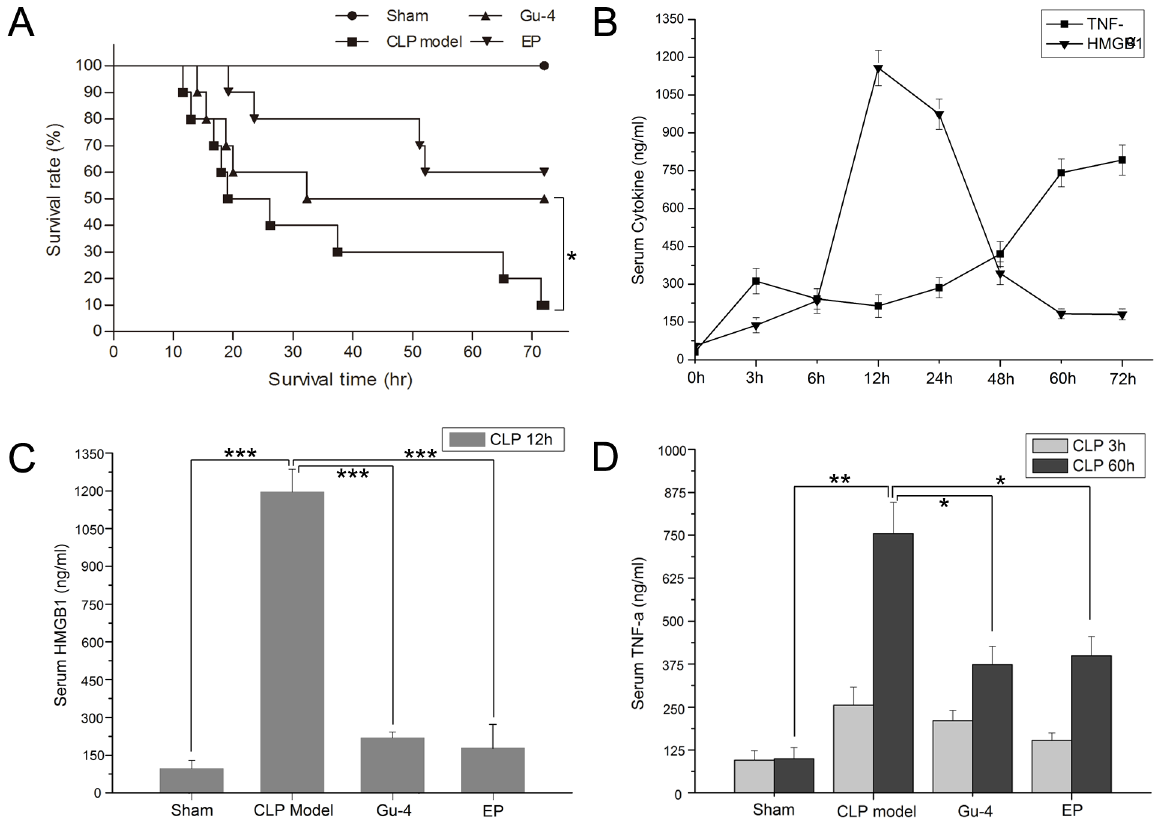
Figure 1. Gu-4 improves survival in septic rats and this improvement is accompanied by marked decrease of HMGB1 and TNF- a level in serum. A: Kaplan-Meier analysis of sepsis lethality confirmed the significant survival benefit in CLP rats with Gu-4 treatment. Gu-4 (0.929 mg/kg, i.p. ) was first administrated to the animals 30 min after CLP surgery and was repeated at an interval of 3 h, similar treatment with EP (40 mg/kg, i.p. ) or saline were taken as controls. (n=10 rats/group) B: The kinetics of serum HMGB1 and TNF- a in a rat model of CLP-induced sepsis. (n=3 rats/group) C: Gu-4 treatment markedly attenuated HMGB1 release in rats 12 h after CLP. (n=5 rats/group) D: Gu-4 treatment abolished the second peak of serum TNF- a in rats 60 h after CLP. (n=5 rats/group) Animals in C and D were undergone the same treatments as those in A. Values are mean 6 S.D. *, p , 0.05; **, p , 0.01; ***, p , 0.001.